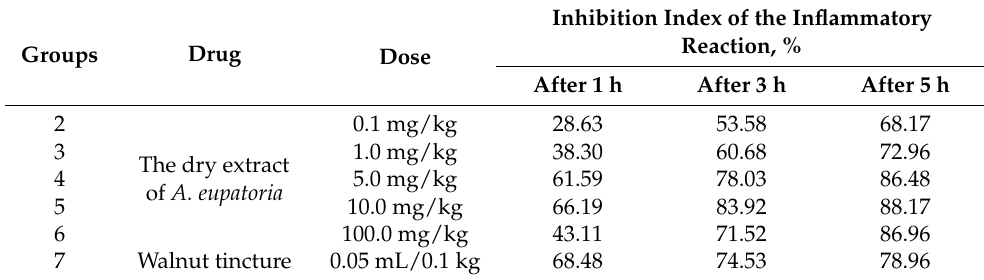
Table 5. Anti-exudative activity of the herb extract of A. eupatoria .